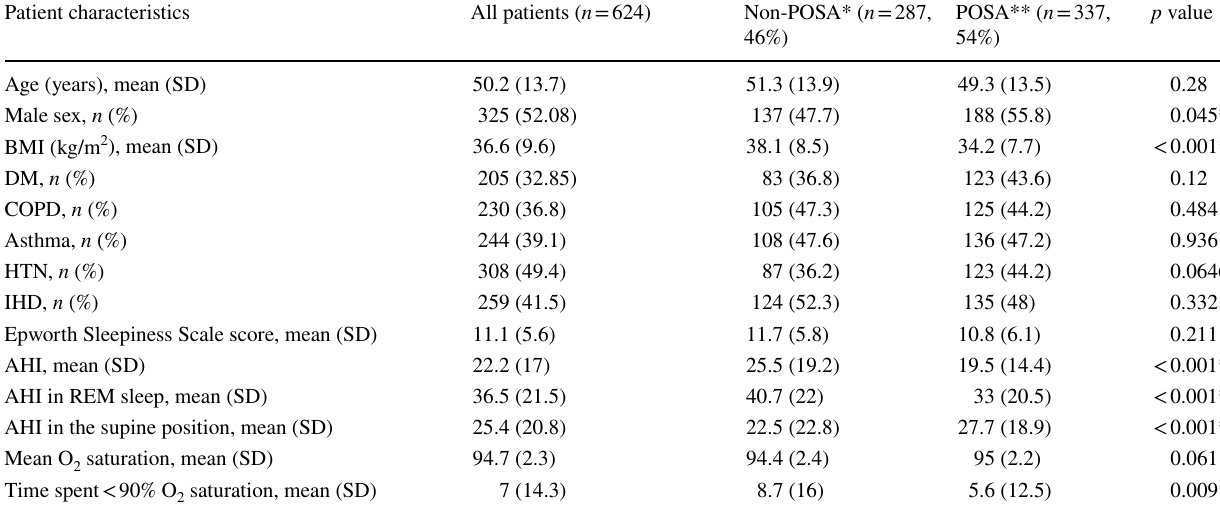
Table 2 General characteristics of patients classified according to POSA Definition 1